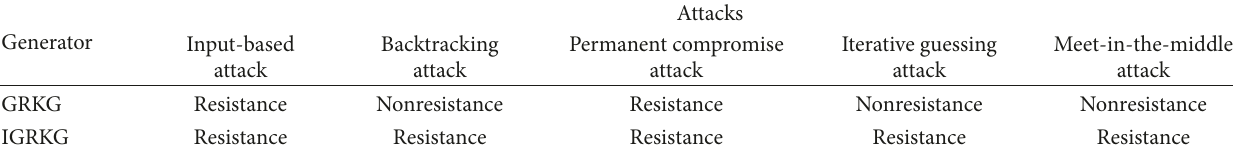
Table 15: Cryptanalytic